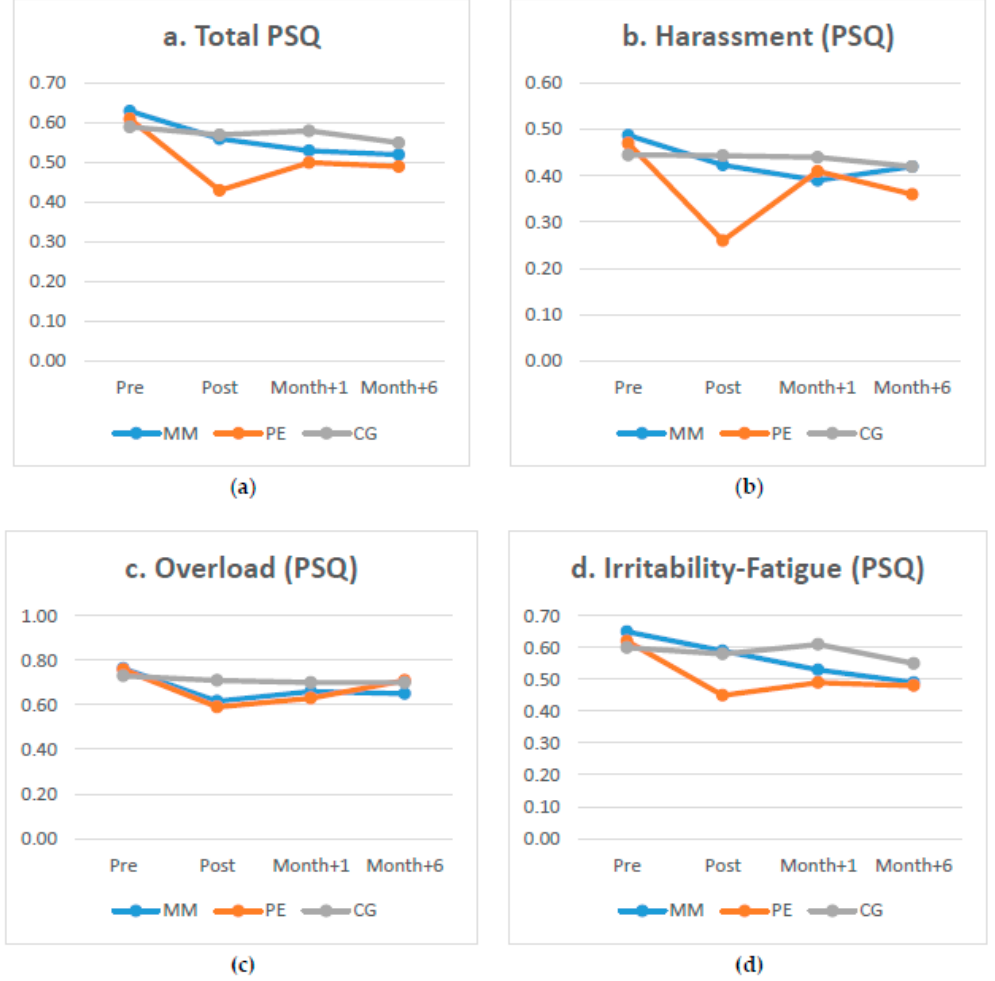
Figure 2. ( a ) Perceived Stress Questionnaire (PSQ) ( b ) Harassment-Social acceptance of the Perceived Stress Questionnaire (PSQ) ( c ) Overload dimension of the Perceived Stress Questionnaire (PSQ) ( d ) Irritability-Tension-Fatigue dimension of the Perceived Stress Questionnaire (PSQ).